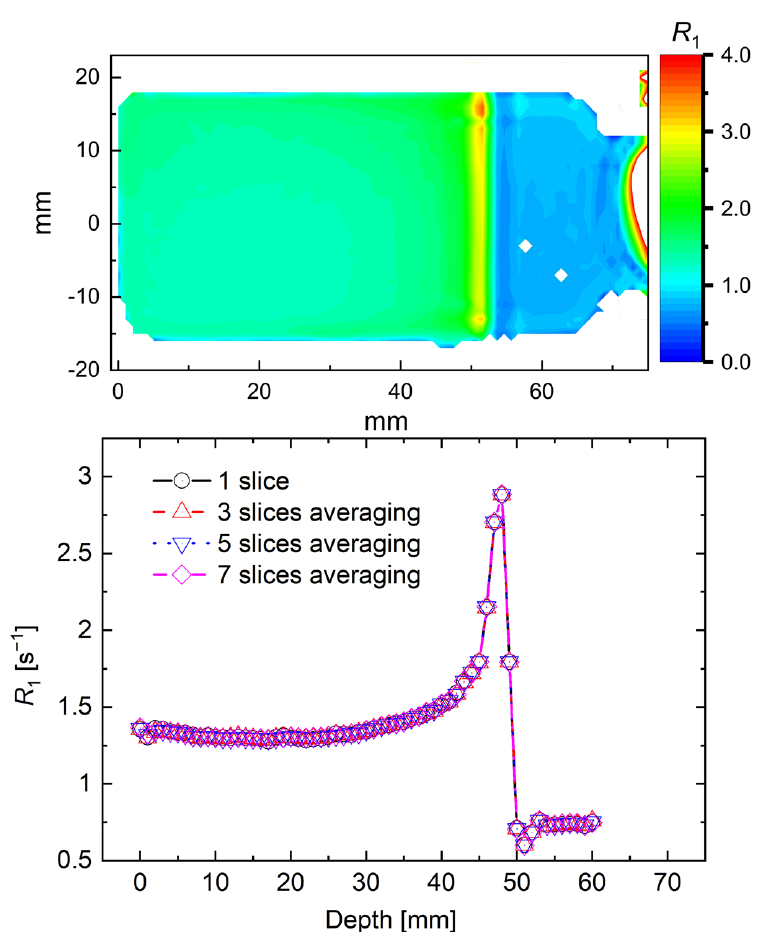
Figure 2. R 1 distribution measured with VFA methods after irradiation with a 290 MeV/u carbon beam for NC-FG at 600 Gy ESD dose. Upper panel: 2D map, lower panel: line profile obtained from the 2D map.